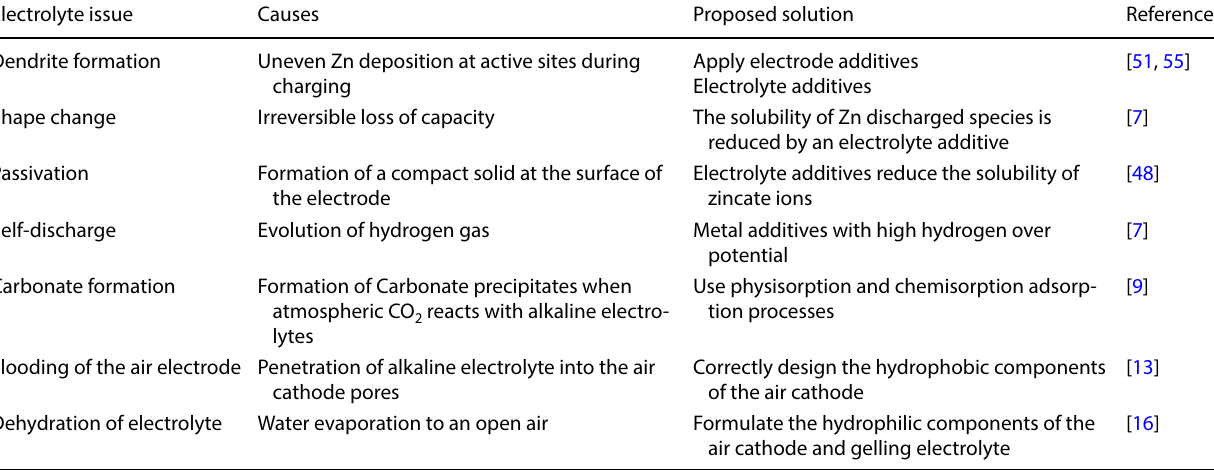
Table 4 Major challenges in aqueous electrolyte and proposed solution for RZABs Electrolyte issue